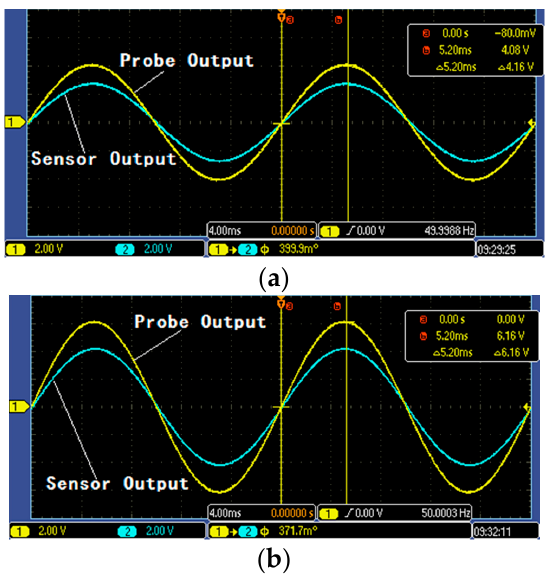
Figure 22. Comparison figure of high-voltage probe and voltage sensor: ( a ) signals comparison under 4 kV; and ( b ) signals comparison under 6 kV.